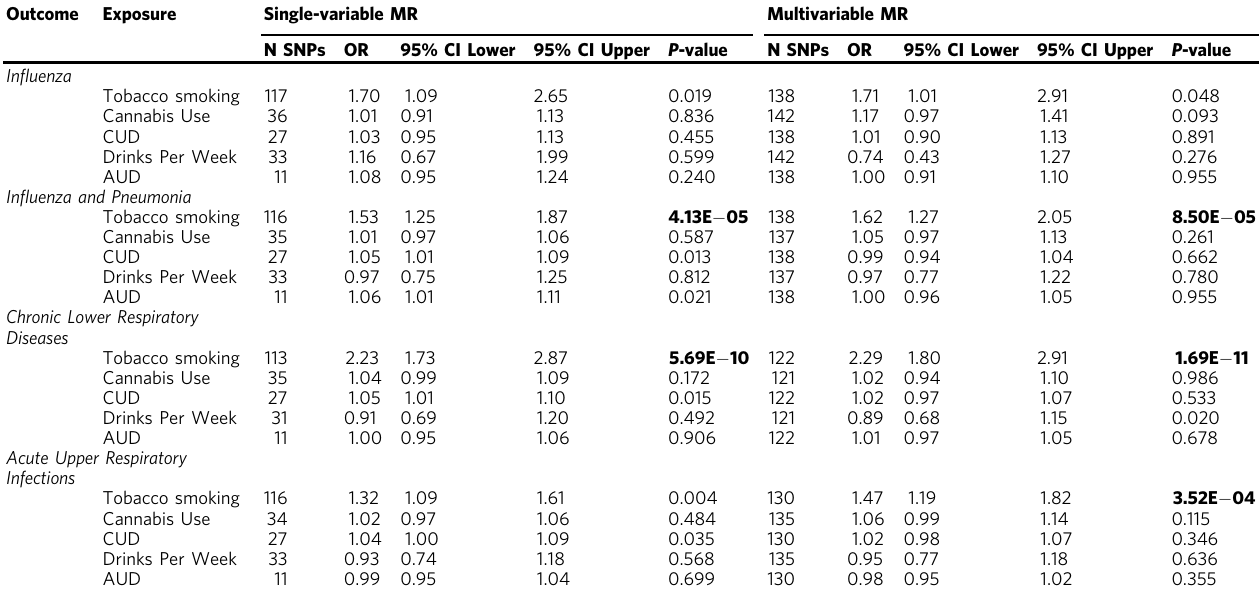
Table 4 Single variable and multivariable MR results of the genetic liability of alcohol, cannabis and lifetime smoking exposures on in fl uenza, chronic lower respiratory diseases, and acute upper respiratory infections. Outcome